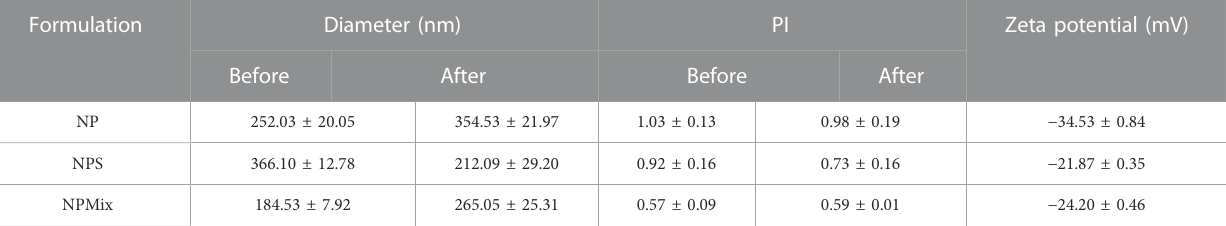
TABLE 2 Average diameter and dimensional distribution (PI), before and after spray drying process, and zeta potential of the nanoparticles. Data are reported as mean values ± standard deviation, n = 3 or 9. Formulation Diameter (nm) Zeta potential (mV) Before After Before